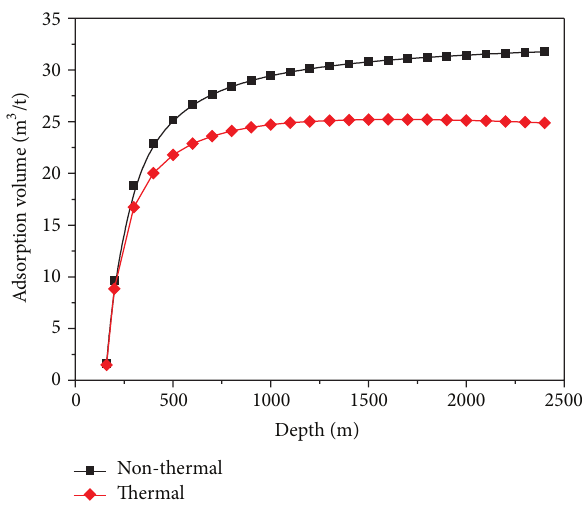
Figure 10: Changes of adsorption volume of the No. 3 coal seam with the depth in the